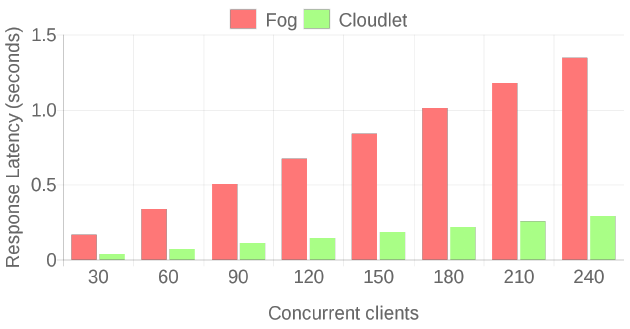
Figure 11. Latencies for 64KB and 30 to 240 concurrent